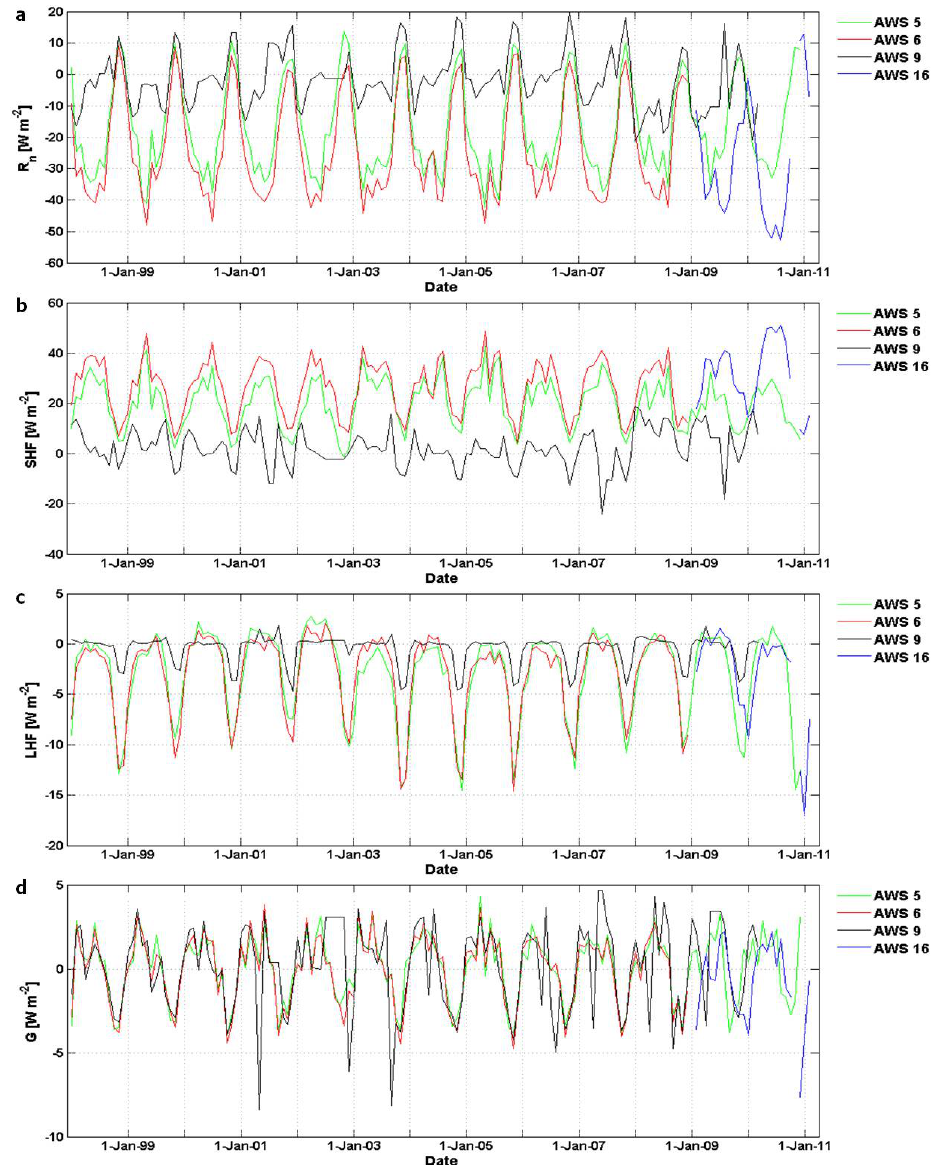
Fig. 6. Monthly mean surface energy balance components (Wm − 2 ) at AWS 5, 6, 9 and 16, respective measurement periods: (a) net radiation R n , (b) sensible heat flux SHF, (c) latent heat flux LHF, (d) subsurface conductive heat flux G . Not shown is melting energy M , as this energy flux is absent at AWS 6, 9 and 16 and negligible at AWS